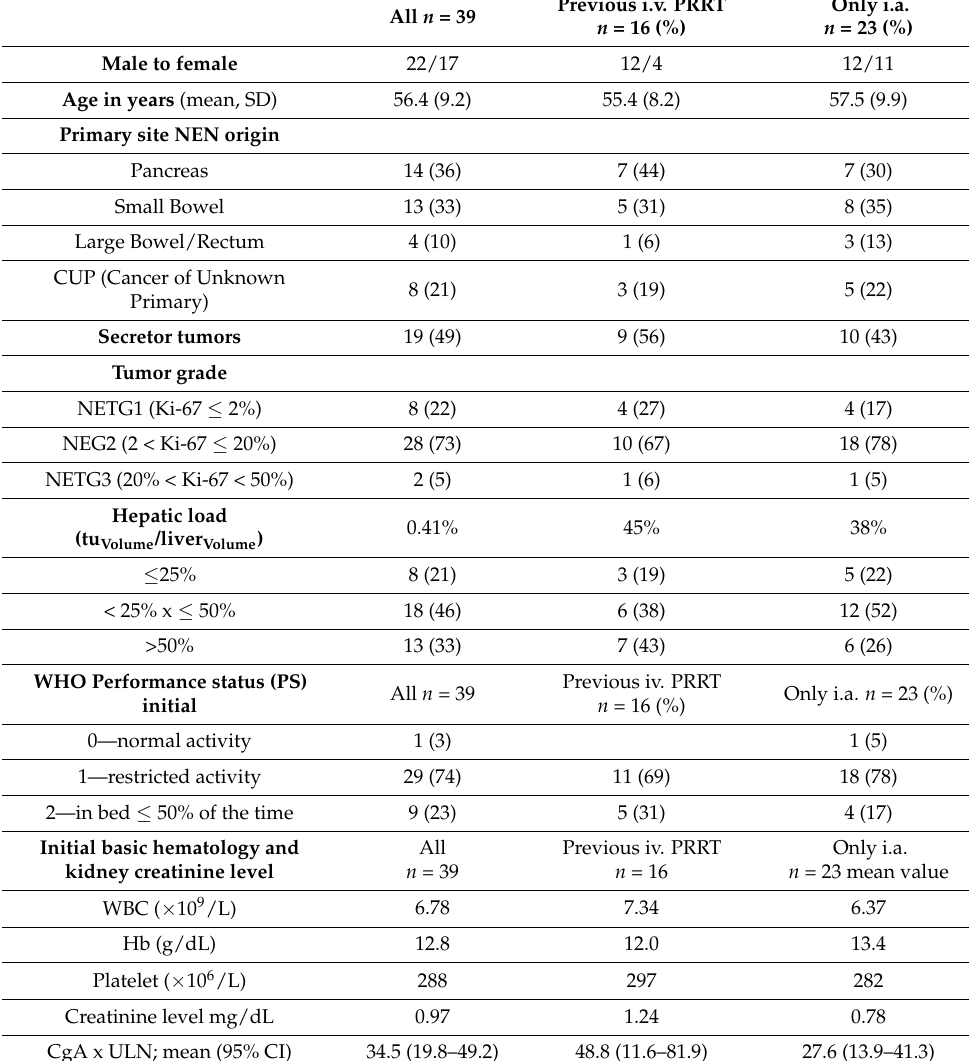
Table 1. Clinical data of all patients and those with previous i.v. PRRT and native i.a. PRRT. Previous i.v. PRRT Only i.a. All n = 39 n = 16 (%) n = 23 (%) Male to female 22/17 12/4